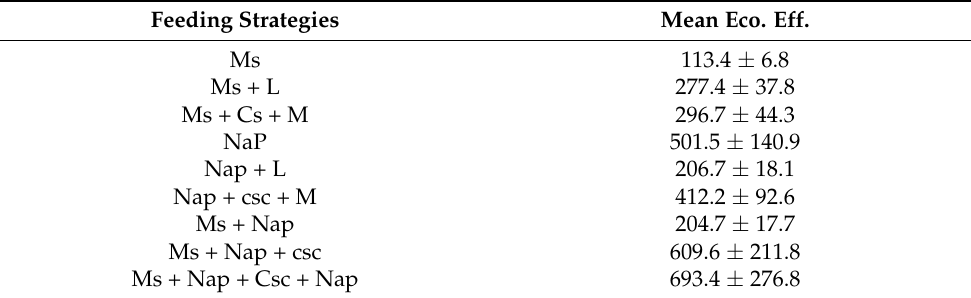
Table 6. Comparison of ecoefficiency between various dairy feeding strategies. Feeding